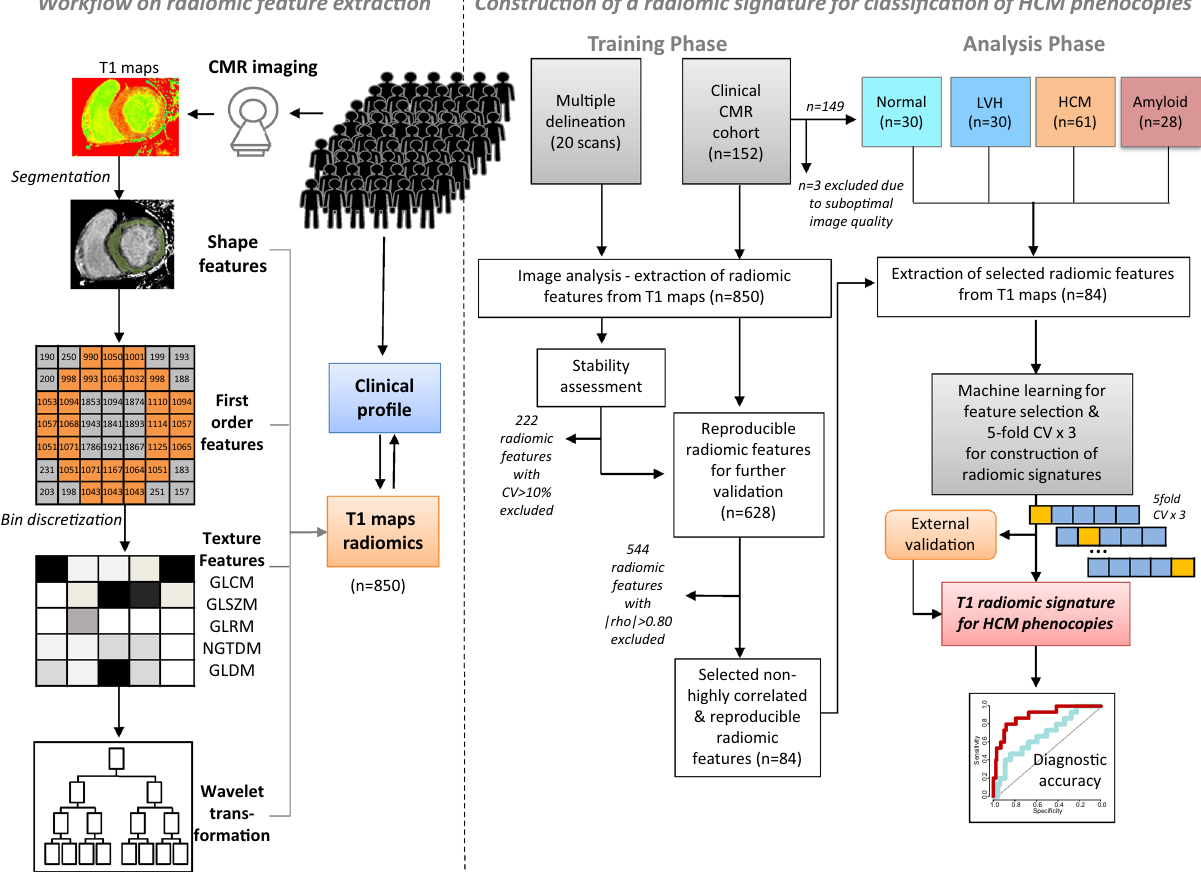
Figure 1. Study flow-chart. CMR cardiac magnetic resonance, CV coefficient of variation, GLCM gray level co-occurrence matrix, GLDM Gray Level Dependence Matrix, GLRM Gray Level Run-Length Matrix; GLSZM Gray Level Size Zone Matrix, HCM hypertrophic cardiomyopathy; LVH left ventricular hypertrophy; NGTDM Neighboring Gray Tone Difference